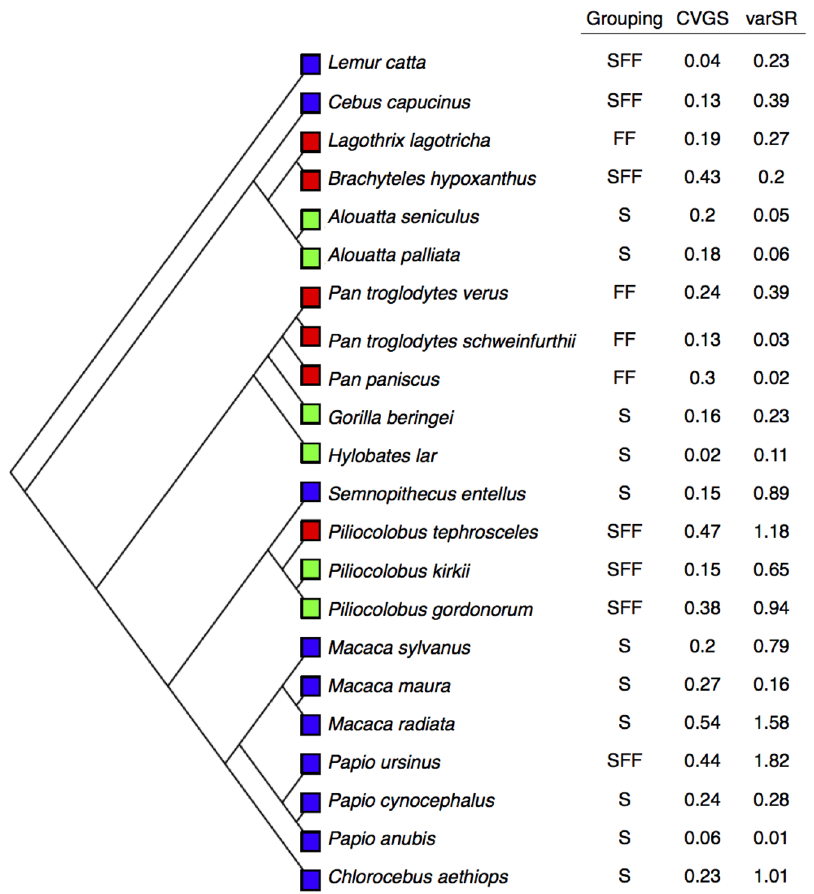
Figure 1. Distribution of Dispersal regimes (blue: Male-biased; red: Female-biased; green: Bi-sexual) among the 22 primate species in our study. Grouping (S 5 stable; FF 5 fission-fusion; SFF 5 sometimes fission-fusion), CV in Group size (CVGS), and variation in Sex ratio (varSR 5 100*variance in arcsine square- root transformed sex ratio; see Table